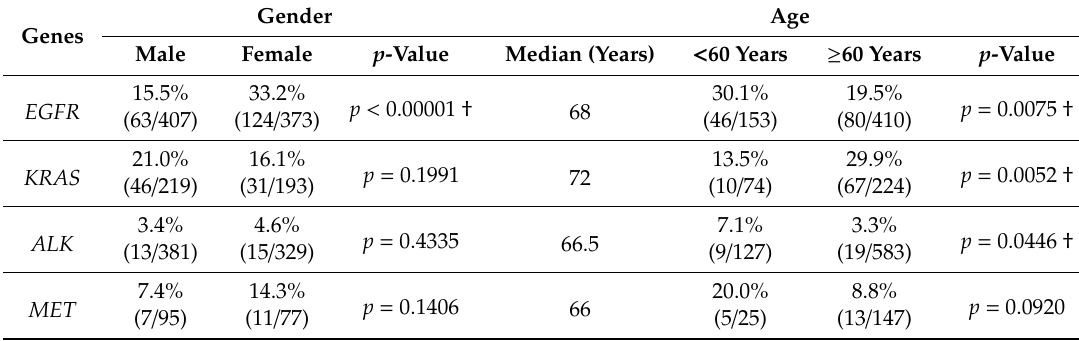
Table 3. Gene alterations in relation to gender and age.